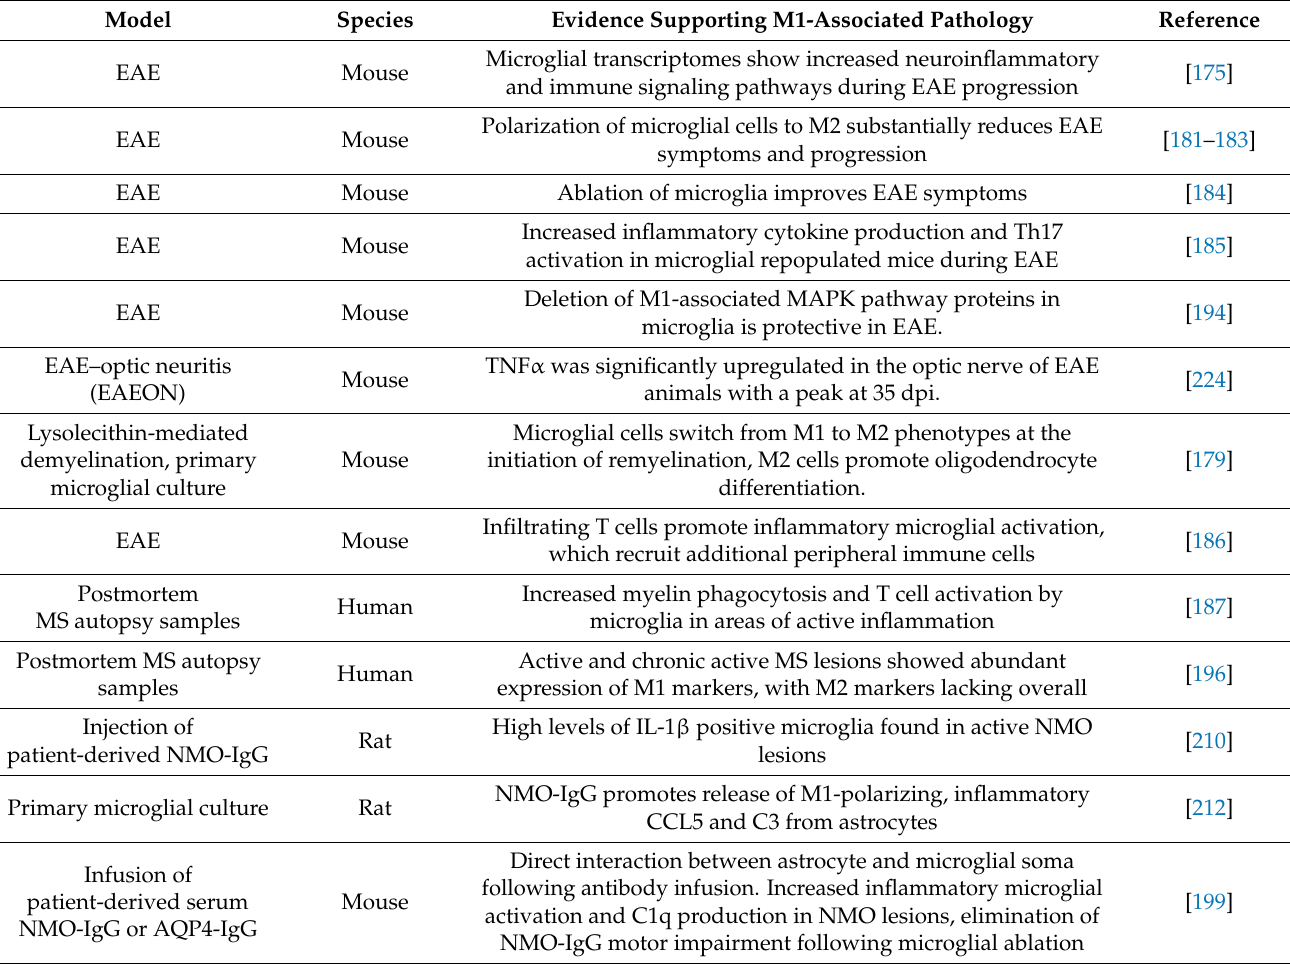
Table 3. M1 microglia drive CNS autoimmune